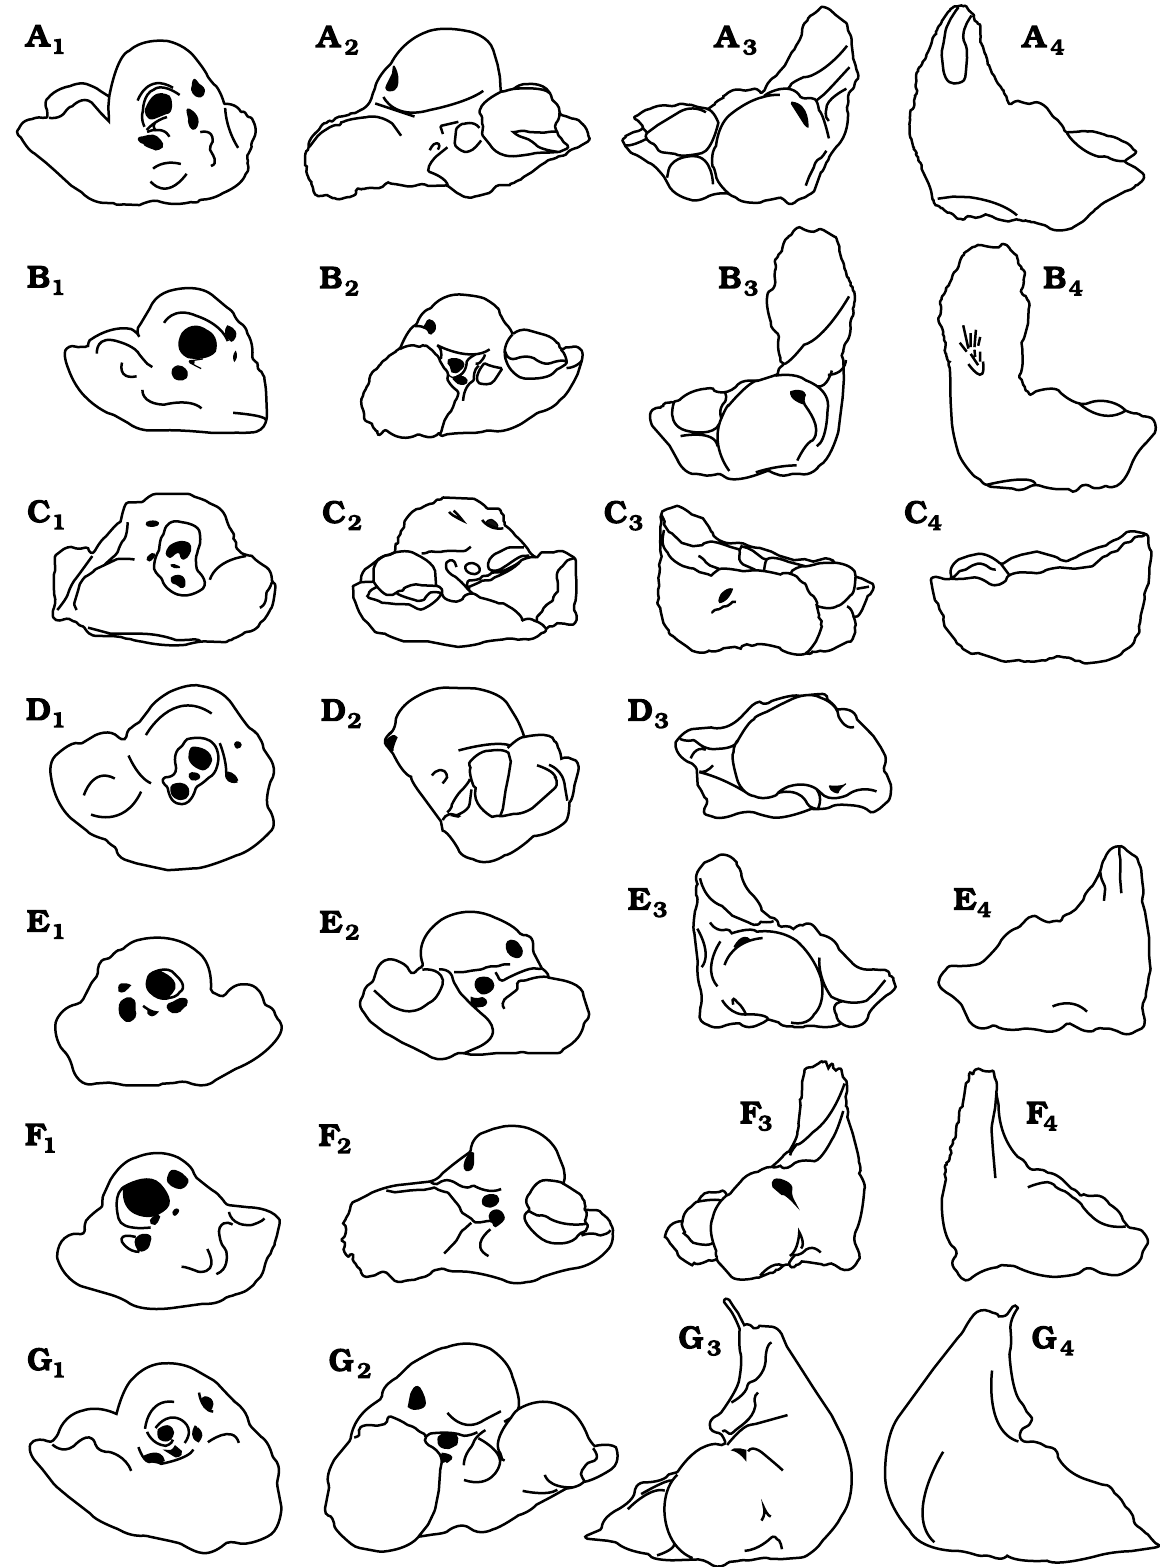
Fig. 5. Schematic comparisons of the periotic of MLP 76-IX-5-1, “ Preaulophyseter gualichensis ” Caviglia and Jorge, 1980 ( A ) with “ Aulophyseter ” rioneg- rensis ( B ), Acrophyseter deinodon ( C , modified from Lambert et al. 2016), Zygophyseter varolai ( D , modified from Bianucci and Landini 2006), Aulophyseter morricei ( E , modified from Kellogg 1927), Orycterocetus crocodilinus ( F , modified from Kellogg 1965), and Physeter macrocephalus ( G , modified from Kasuya 1973). In dorsal (A 1 –G 1 ), ventral (A 2 –G 2 ), medial (A 3 –G 3 ), and lateral (A 4 –C 4 , E 4 –G 4 ) views. Black areas indicate anatomical foramina. Not to